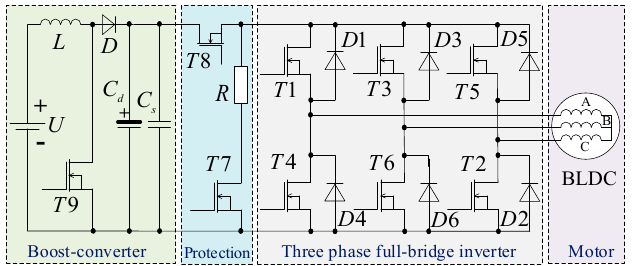
Figure 1. The topology of a boost converter-fed brushless DC (BLDC) motor.